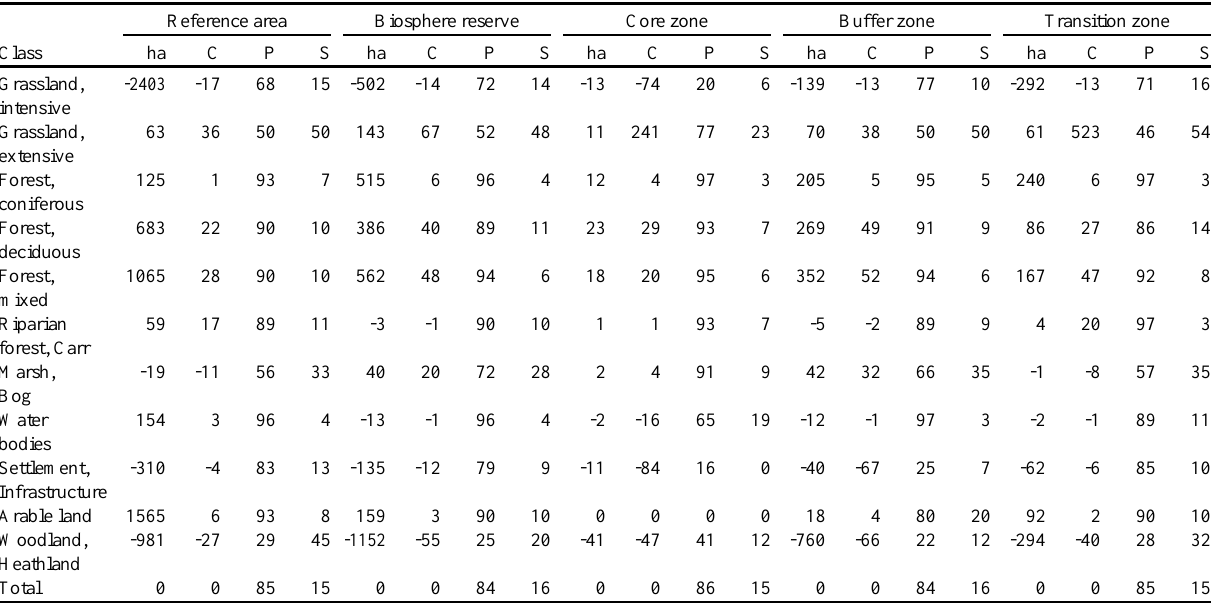
Table 4 . Net change in hectares (ha), net change (C), persistence (P), and swap (S) in percentage of area covered by the respective class in